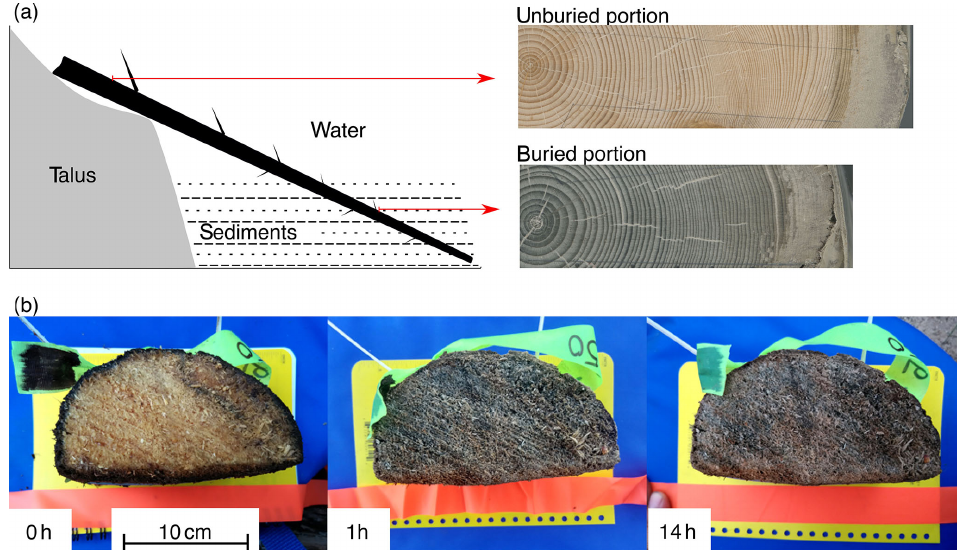
Figure 5. Schema of different cross-sectional colors from the buried and exposed cross sections of the same partially buried tree (a) , and field observations of cross-sectional color changes after a fresh disc was cut from a buried tree and exposed to air (b)